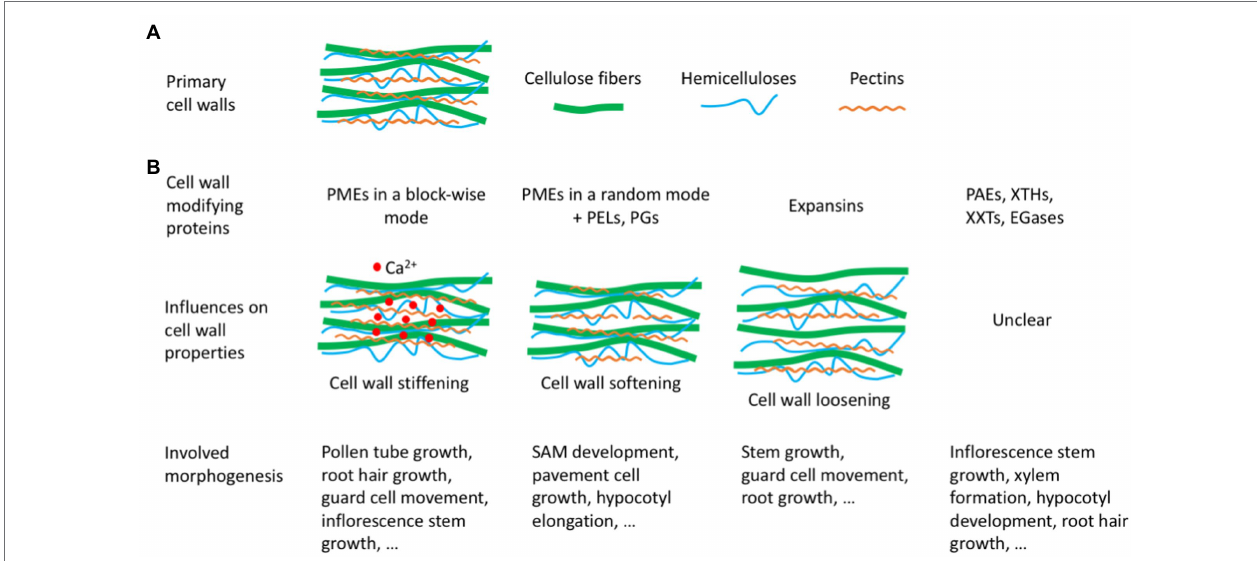
FIGURE 1 | Hypothetical models on the action of cell wall modifying proteins. (A) A simplified schematic depicting the structure of the primary cell wall. (B) The potential action mechanisms of different cell wall modifying proteins. PMEs, pectin methylesterases; PELs, pectate lyases; PGs, polygalacturonases; PAEs, pectin acetyl esterases, XTHs, xyloglucan endotransglucosylases/hydrolases; XXTs, xylosyltransferases; EGases, endo-1,4- β